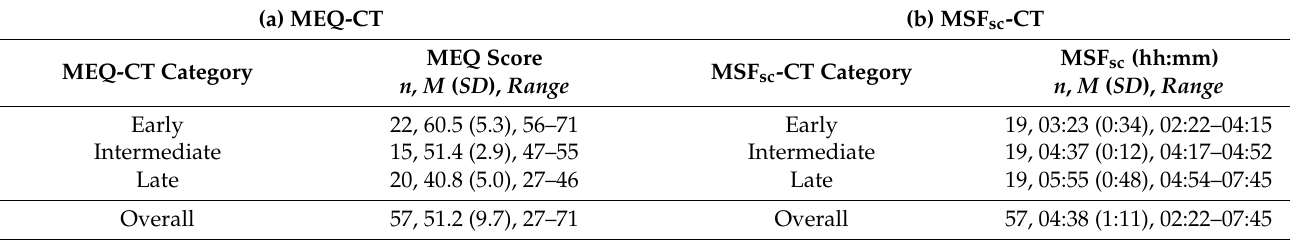
Table 2. ( a ) Means, standard deviations, and ranges of MEQ Score for MEQ-CT categories; ( b ) Means, standard deviations and ranges of MSF sc for MSF sc -CT